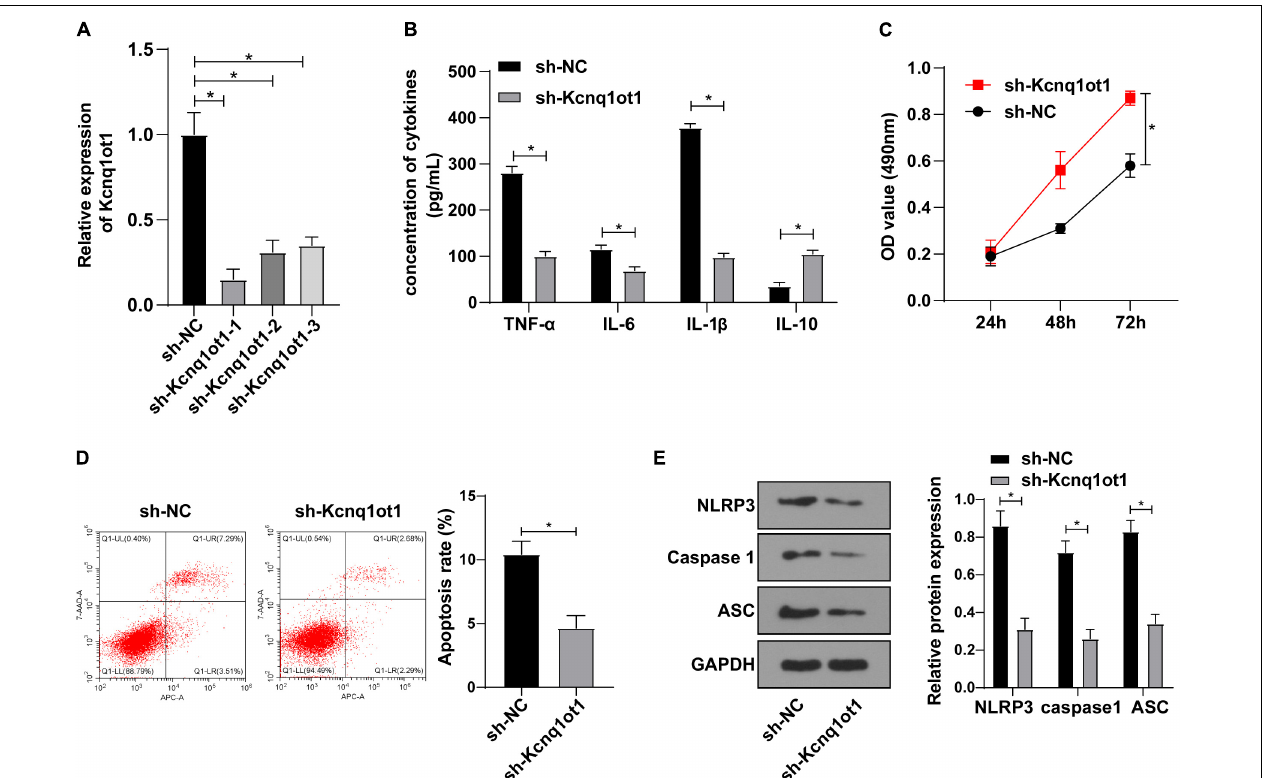
FIGURE 2 | Kcnq1ot1 knockdown inhibited inflammation in the H/R model of HK-2 cells in vitro . (A) Transfection efficiency of Kcnq1ot1 in H/R model of HK-2 cells was detected by RT-qPCR; (B) levels of TNF- α , IL-6, IL-1 β , and IL-10 in the supernatants were detected by ELISA; (C) cell viability was detected by CCK-8 assay; (D) cell apoptosis was detected by flow cytometry; (E) levels of NLRP3 inflammasome related factors were detected by Western blot. All data in this figure were measurement data and presented as M ± SD . Comparison between two groups was analyzed using an independent sample t -test, while comparison among groups at different time points was analyzed using the repeated measures ANOVA, followed by Bonferroni’s post hoc test. * P < 0.05. The experiment was repeated three